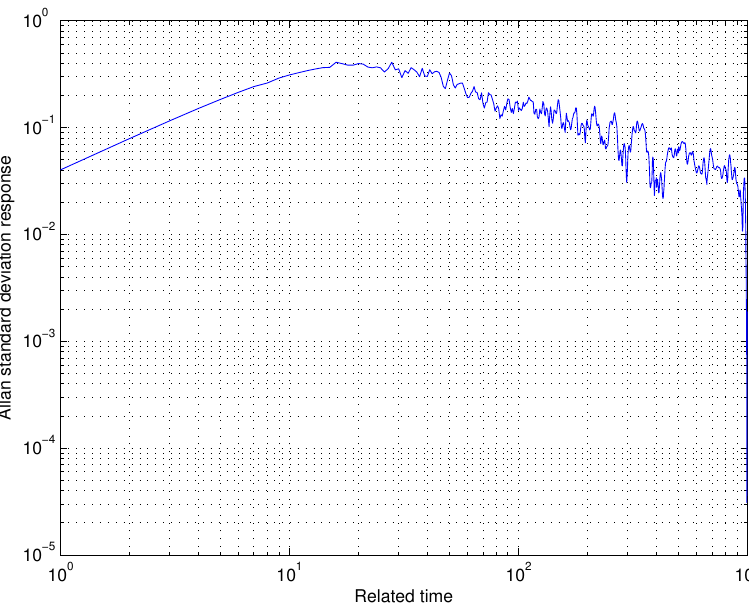
Figure 10. Allan variance after compensation.